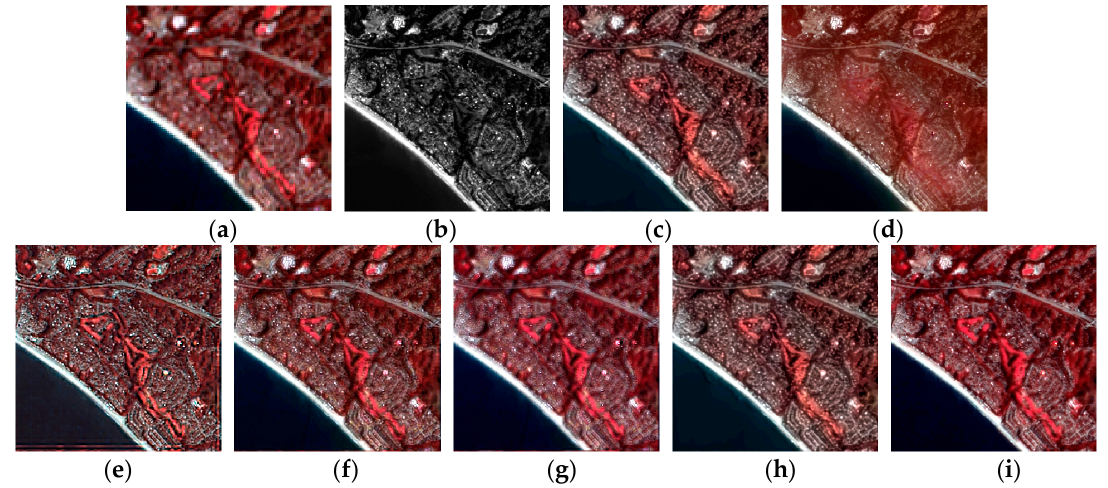
Figure 12. Visual comparison of different hyperspectral pan-sharpening methods for Hyperion dataset. ( a ) Interpolated HS image; ( b ) P image; ( c ) PCA; ( d ) GFPCA; ( e ) HySure; ( f )MGH; ( g ) CNMF; ( h ) Sparse Representation; ( i ) Proposed. Table 5. Quality metrics of different methods for Hyperion dataset.